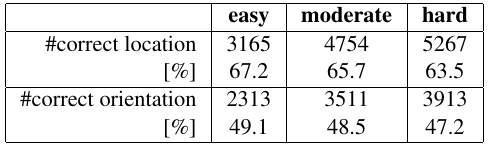
Table 3. Pose estimation results.